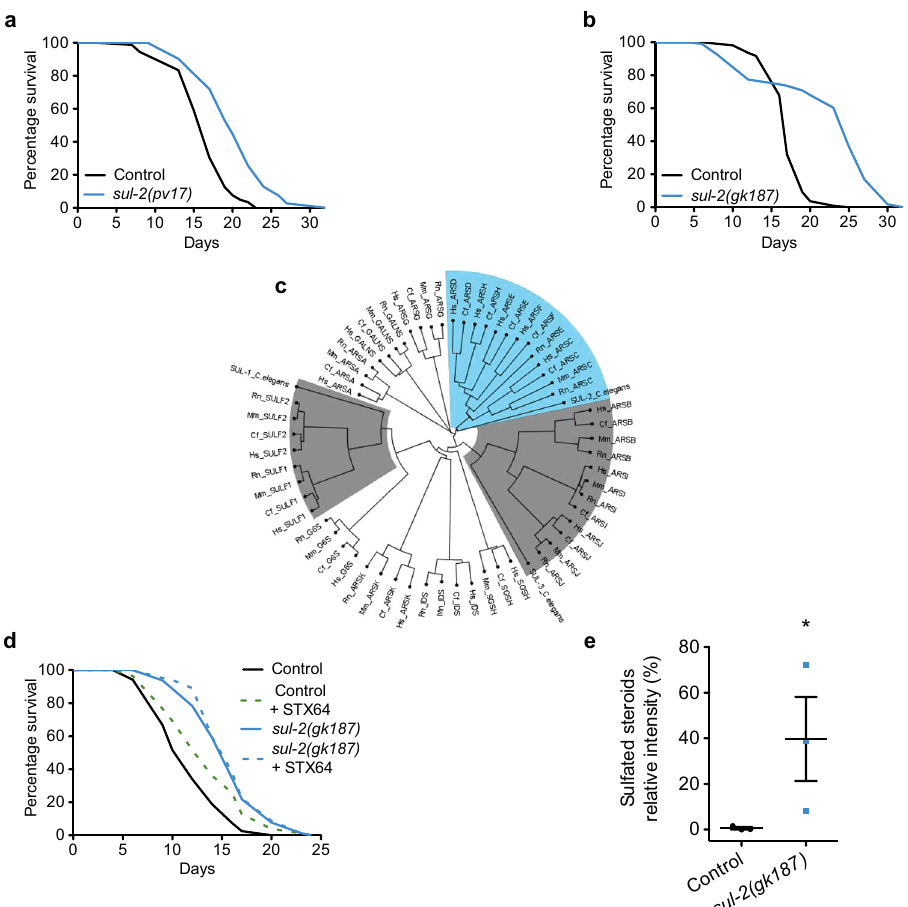
Fig. 1 sul-2 activity reduction increases longevity and the levels of sulfated steroid hormones. a sul-2(pv17) point mutation allele lives longer than wild type. b The null allele sul-2(gk187) also increases lifespan. c Phylogenetic tree of mammalian sulfatases and the three C. elegans sulfatases. Note that SUL-2 clusters with steroid sulfatases (type C) among others, in blue. Phylogenetic relation with other C. elegans sulfatases are indicated in grey. d Inhibition of steroid hormones sulfatase by STX64 (1 μ g/ml) increases lifespan in wild-type animals, but not in sul-2(gk187) background. Worms were cultivated in UV- killed E. coli . e Deletion of sul-2 generates an increase in the percentage of steroid hormones in the sulfated stage. Data from three independent assays are displayed; n ≈ 100,000 worms per sample. Mean± SEM; one-tailed Mann – Whitney t -test; * p = 0.050. Relative quanti fi cation of hormones from independent experiments are shown in Supplementary Table 1. Statistics and additional longevity data are shown in Supplementary Dataset 1. Source data are provided as a Source Data fi